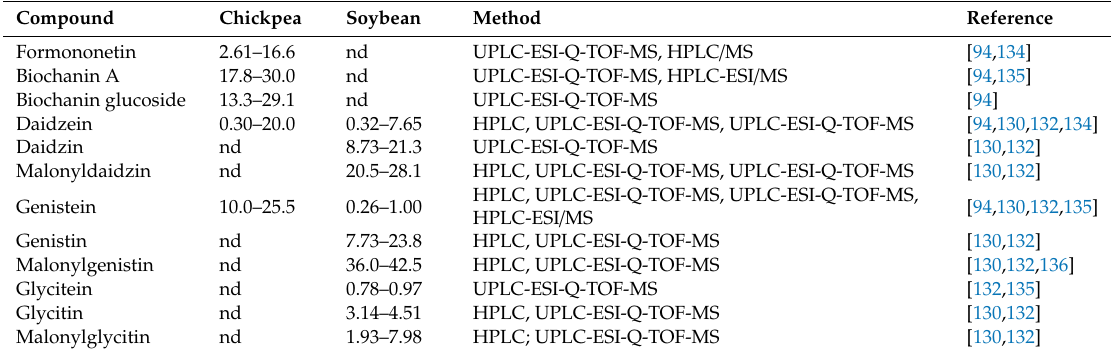
Table 3. Isoflavone profile (%) of chickpea and soybean